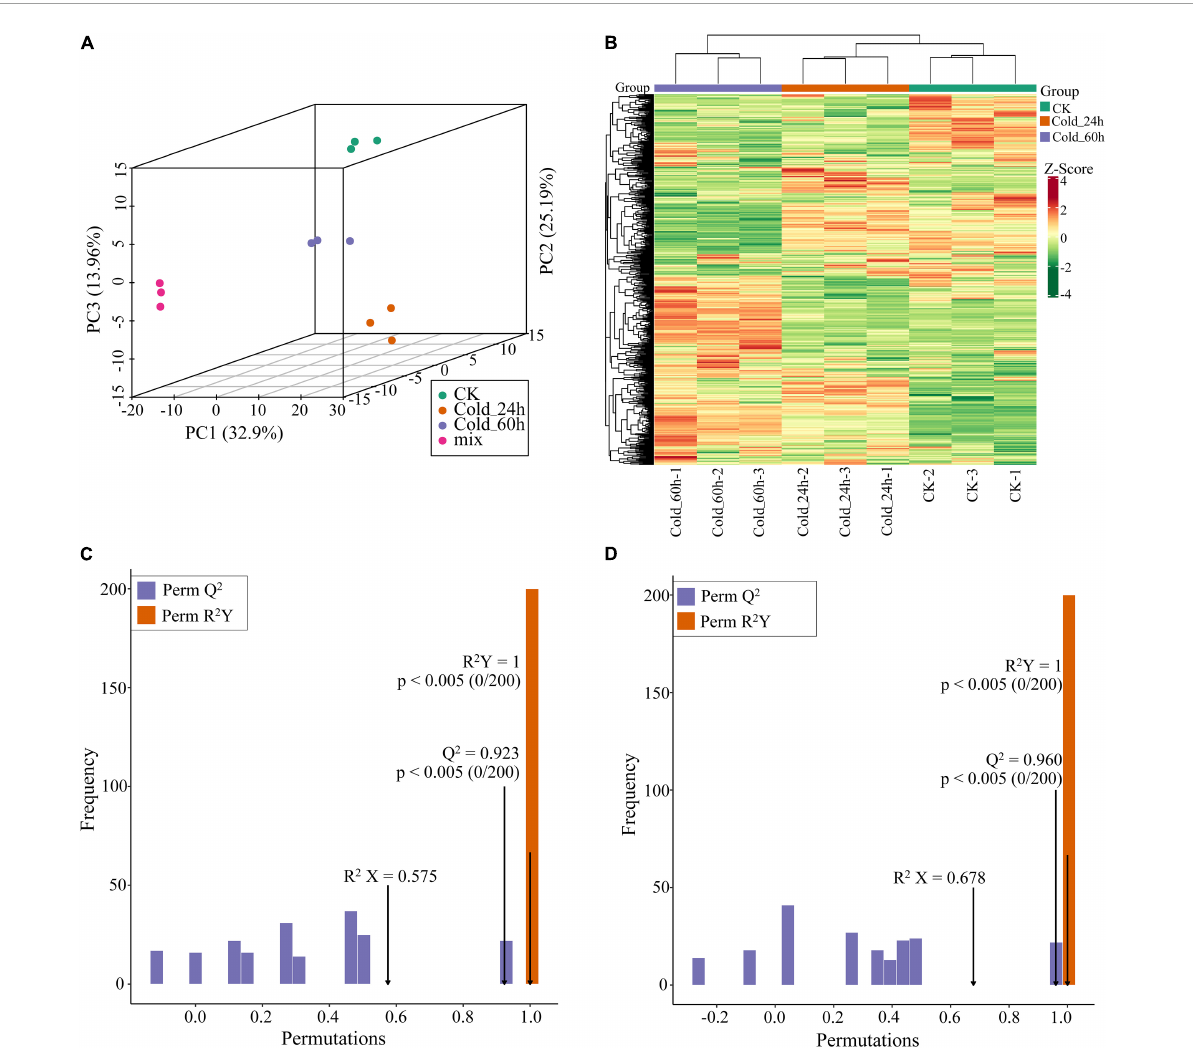
FIGURE2 Multivariate statistical analysis of metabolites in the Antarctic moss Pohlia nutans . (A) Principal clustering analysis (PCA). (B) Hierarchical clustering analysis (HCA). (C,D) The OPLS-DA model supervised and calculated the variables responsible for differences between groups. R 2 X and R 2 Y indicate the interpretation rate of X and Y matrix, respectively. Q 2 Y represents the prediction ability of the model. A value closer to 1 means that the model is more stable and reliable. In addition, Q 2 Y > 0.5 can be regarded as an effective model, and Q 2 Y > 0.9 is an excellent model. C, Cold_24 h vs. CK. D, Cold_60 h vs.